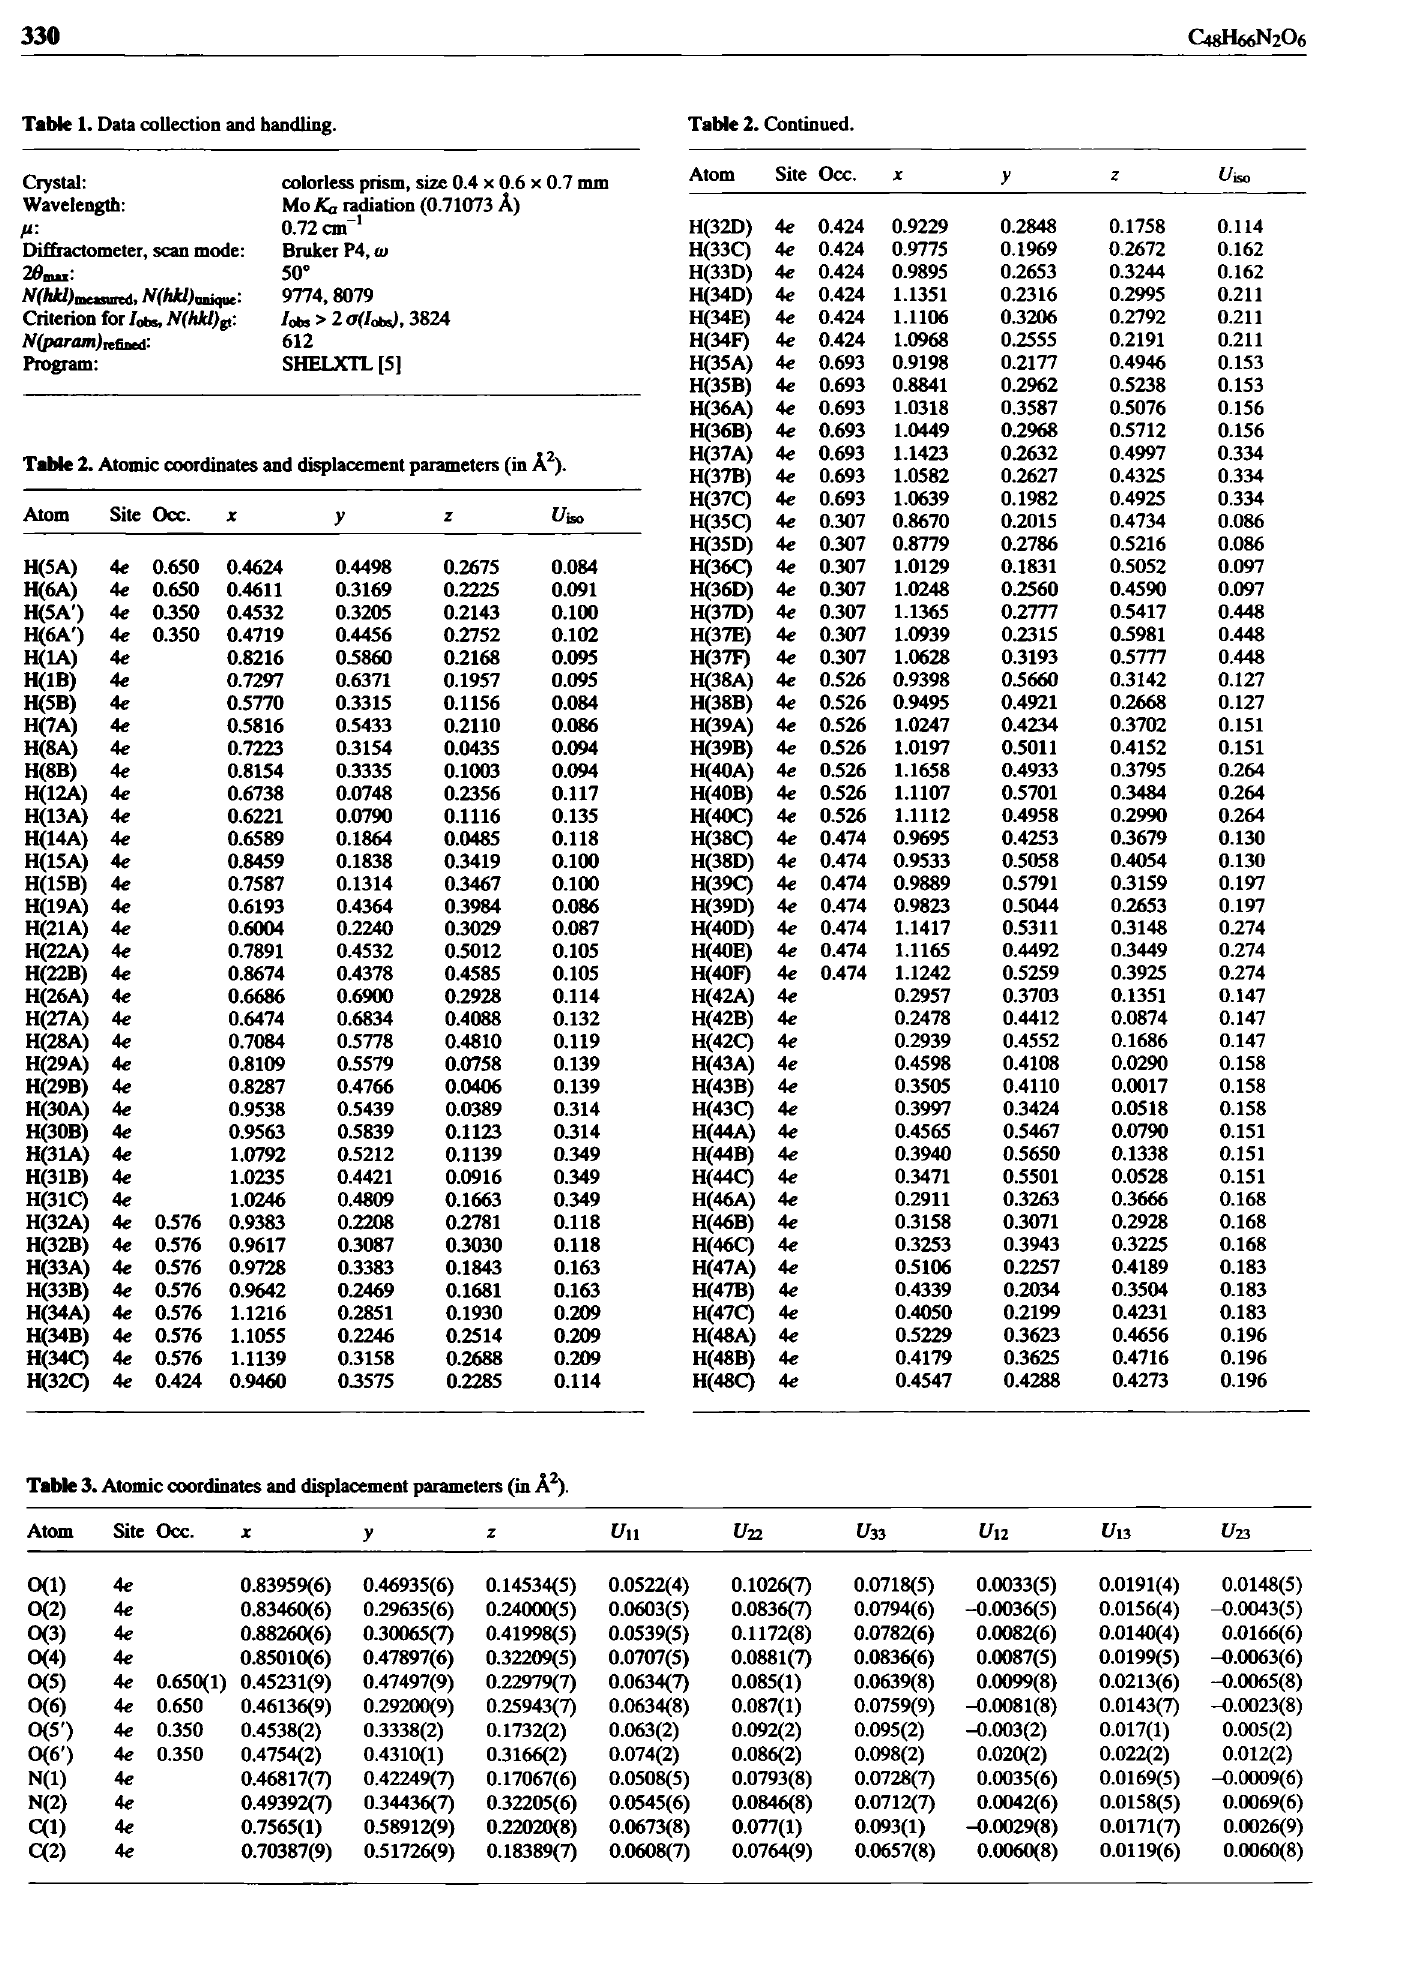
Table 2. Atomic coordinates and displacement parameters (in A 2 ).